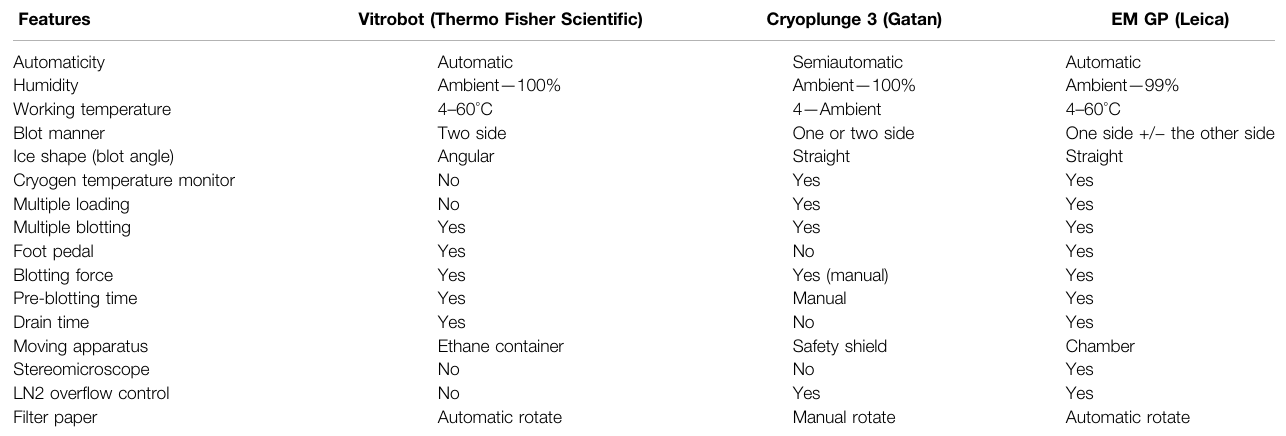
TABLE 3 | Comparison of widely used devices for plunge